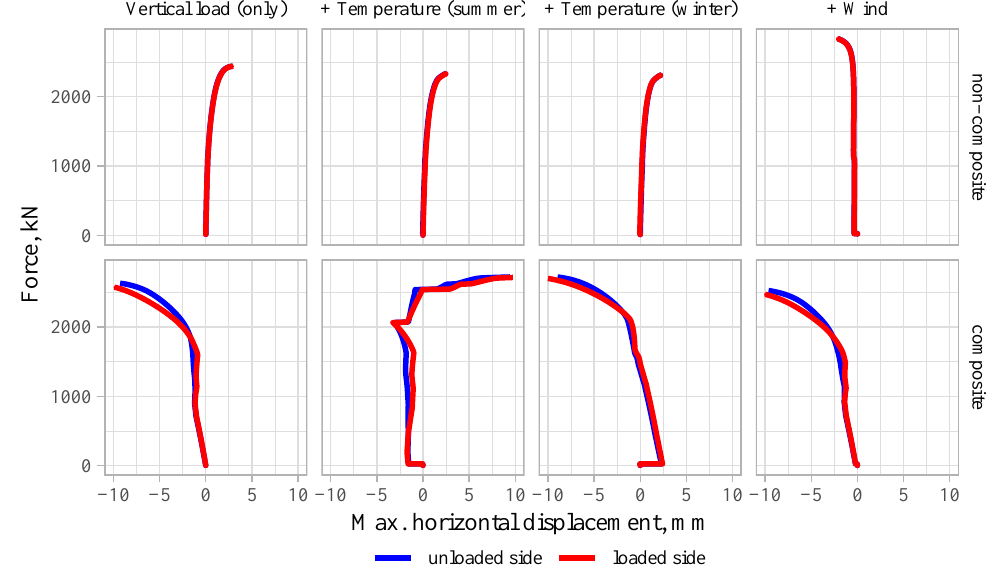
Figure 19. Lateral displacement of the wythes under different load combinations.